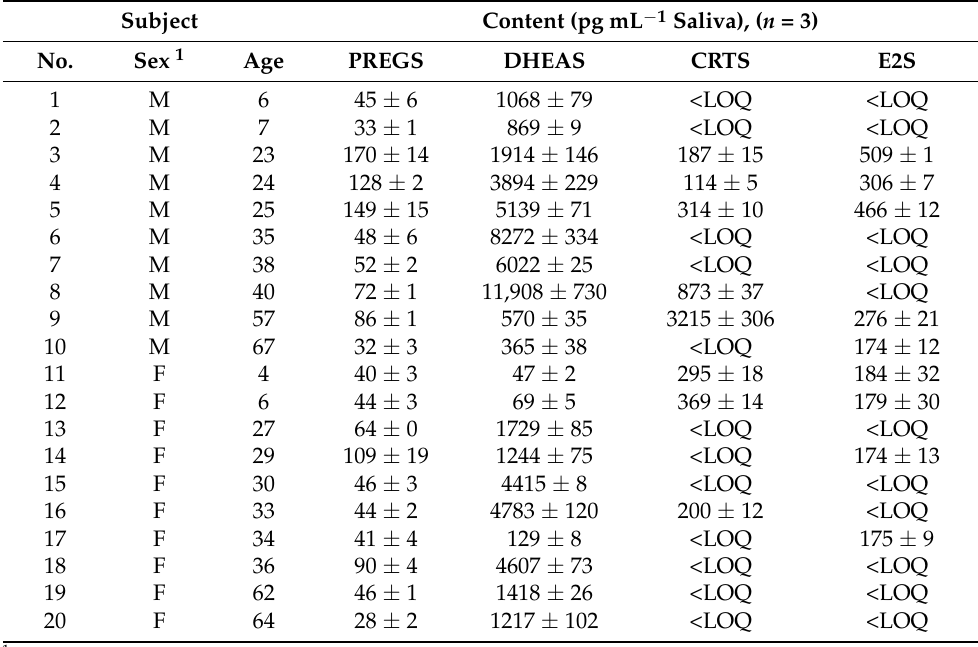
Table 4. Contents of sulfated steroid metabolites in saliva